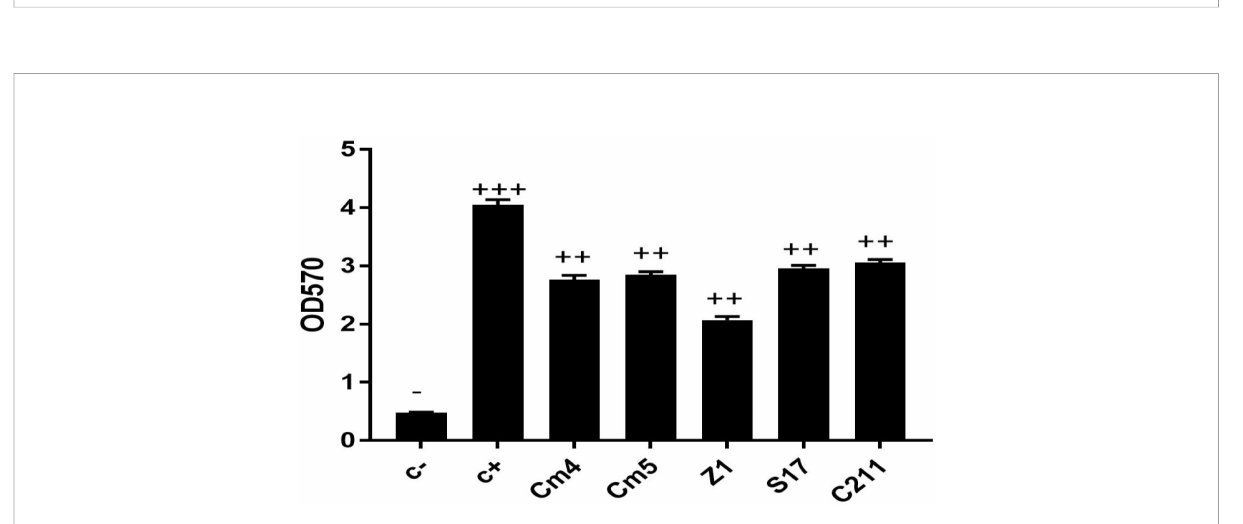
FIGURE 5 Bio fi lm production of selected strains. The ability of bio fi lm production is classi fi ed as follows: OD570 < 1, non-bio fi lm (-); 1< OD570 < 2, weak (+); 2< OD570 < 4, medium (+ +) and OD570>4, strong bio fi lm (+ + +).